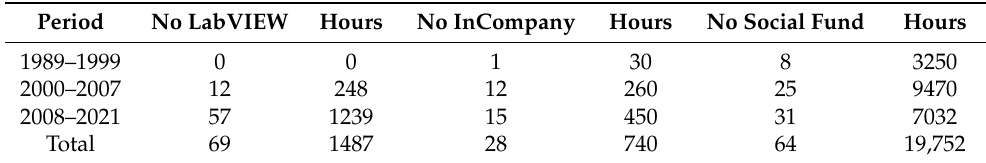
Table 3. Lifelong learning: number of courses and hours, as allocated among In Company, LabVIEW, and European Social Fund. (Total 21,979